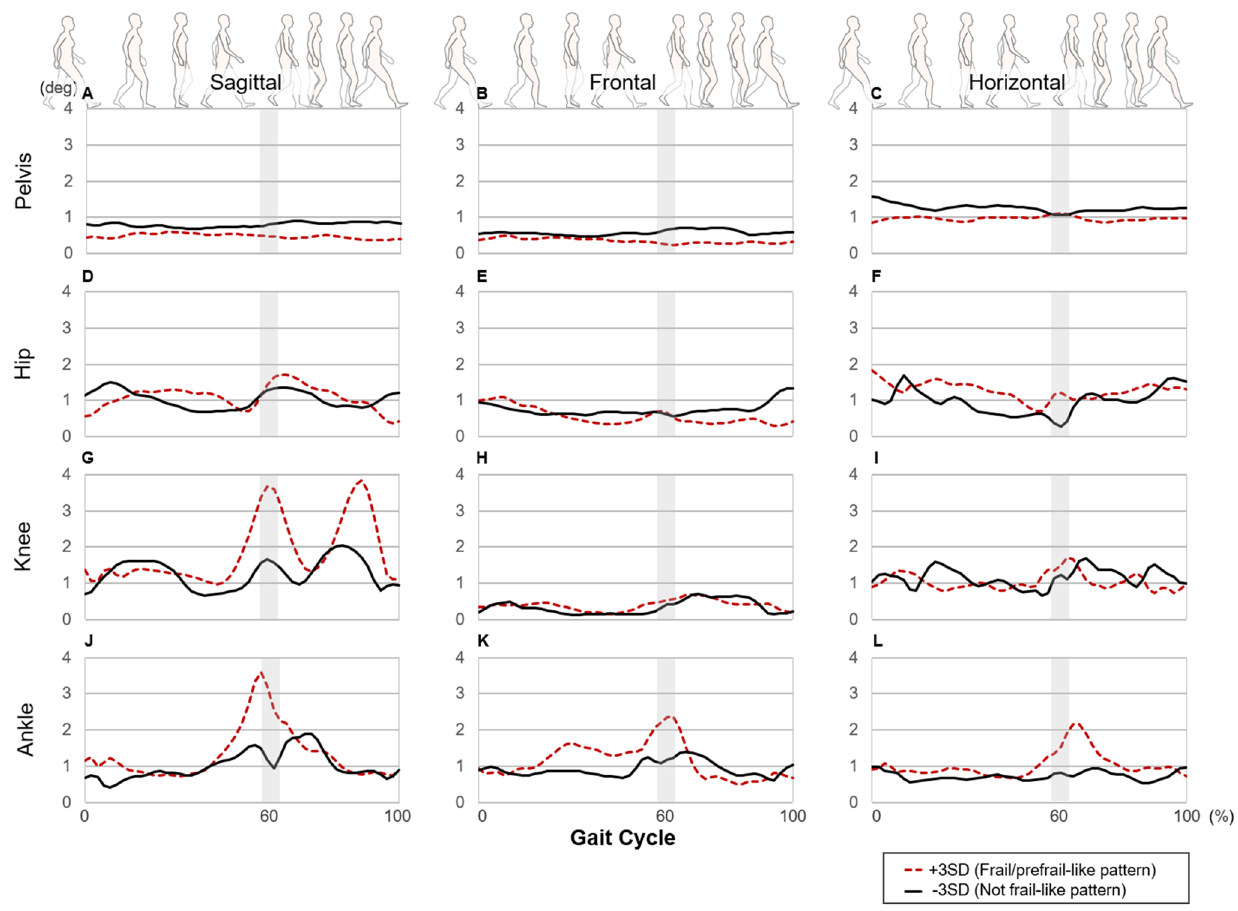
Figure 1. Waveforms of variability (standard deviation: SD) recombined from the principal component scores of principal component vectors 6 and 9. The gray highlighted area indicates the instance of the toe off (the transition from the stance phase to the swing phase). This area has a certain width because we did not separate the stance phase from the swing phase in the time-normalization